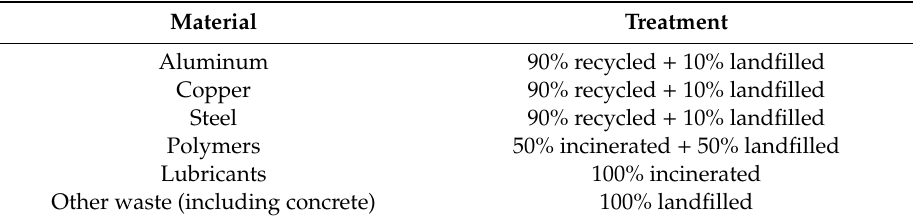
Table 6. The end of life treatment of turbine components.